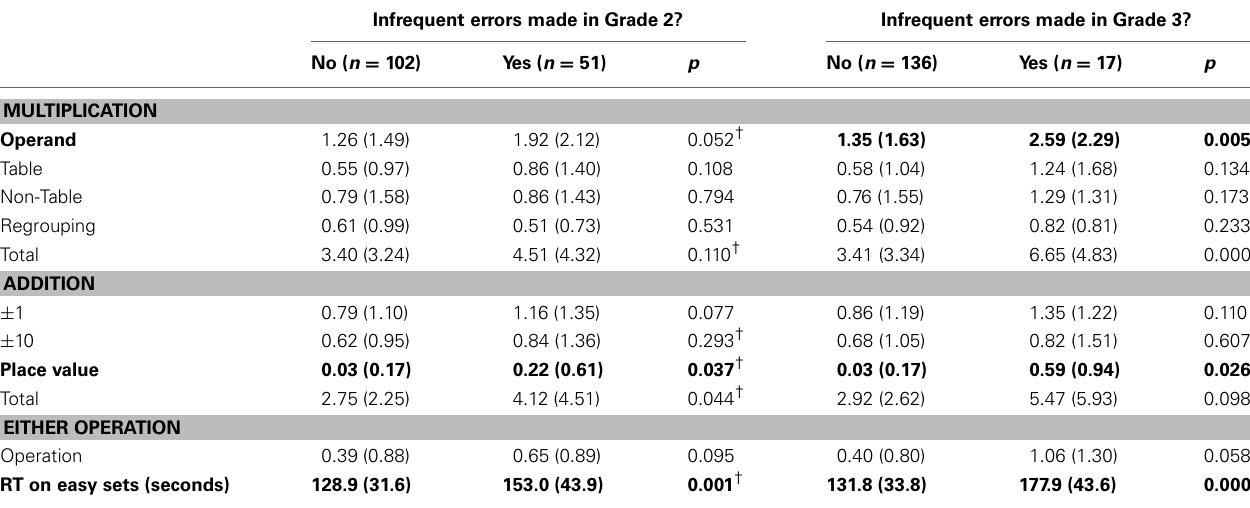
Table 4 | Mean (and SD) number of errors made on 8th grade timed calculation on the Fast Math Test (FMT), as a function of types of calculation errors and whether infrequent errors were made on the Written Numbers Task at Grade 2 or Grade